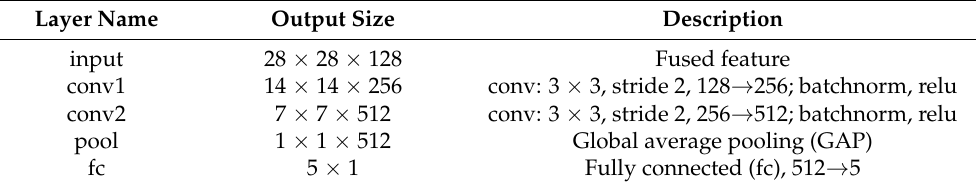
Table 1. Convolutional layer subnet hierarchy (based on the selection of level2/level3/level4).